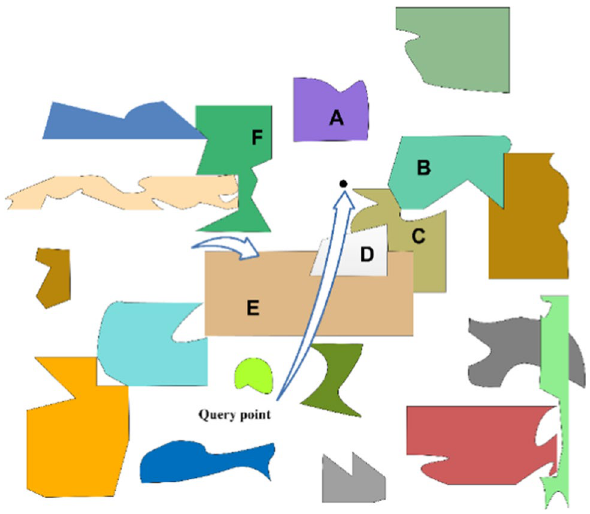
Fig. 5 KNN query operation over a virtual spatial input dataset Fig. 6 KNN query operation over the approximated 2D point